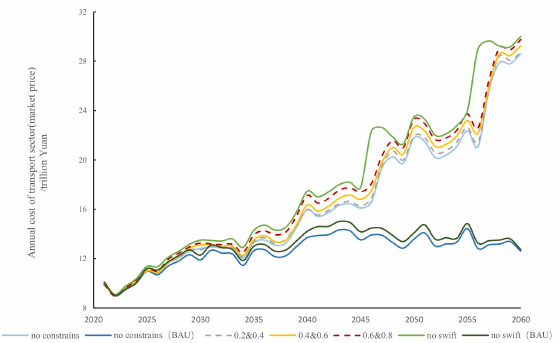
Figure 13. Annual costs of the transport sector with different FIXPRO ser values.